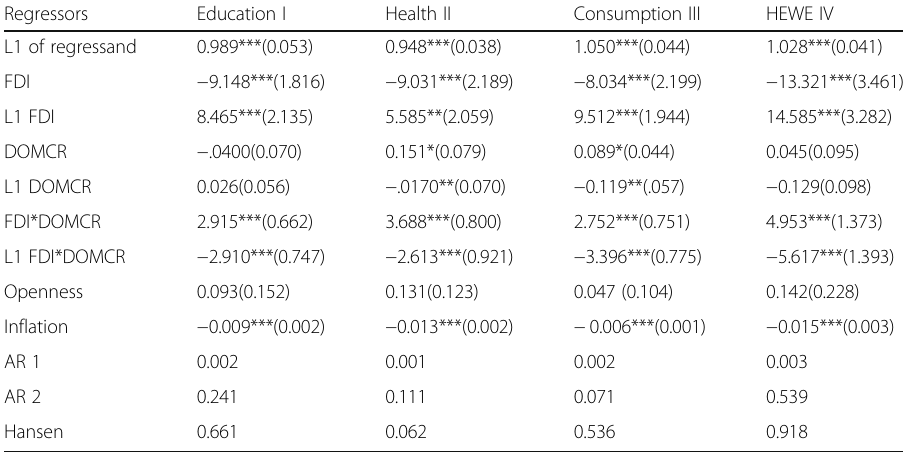
Table 8 Interaction effect of FDI and DOMCR on HEWE, and its components except remittance